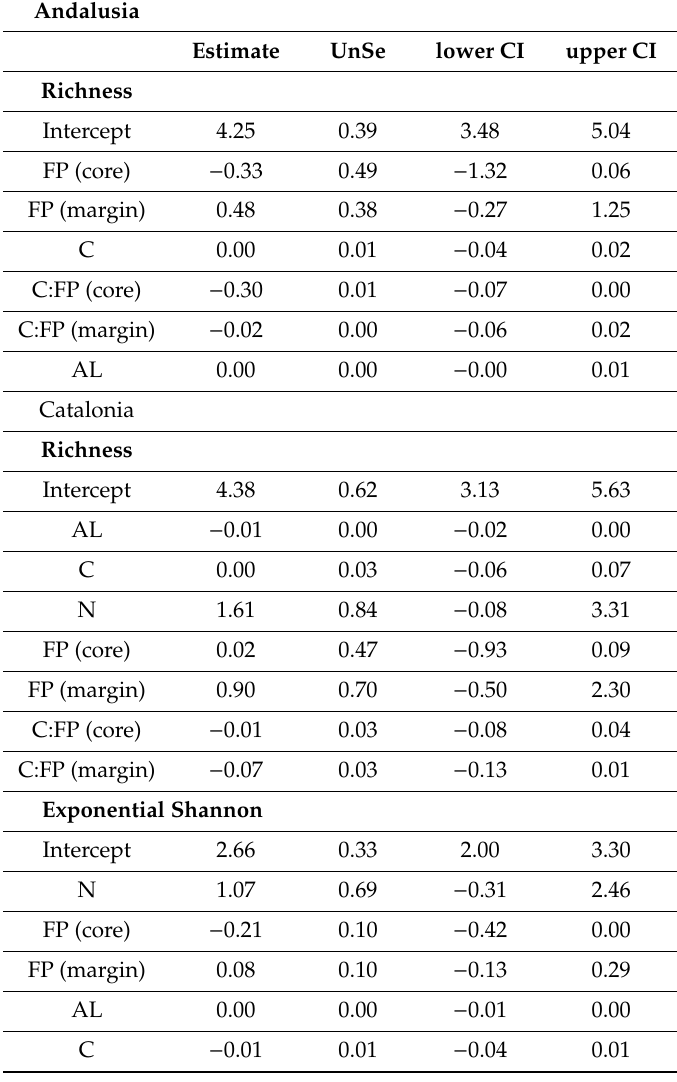
Table 5. Model averaged parameters, unconditional standard error (UnSE), and their 95% confidence intervals (CI) for each of the variables and interactions present within the best set of submodels to explain species richness in Andalusia and Catalonia and the exponential of Shannon index in Catalonia. See Table 1 for